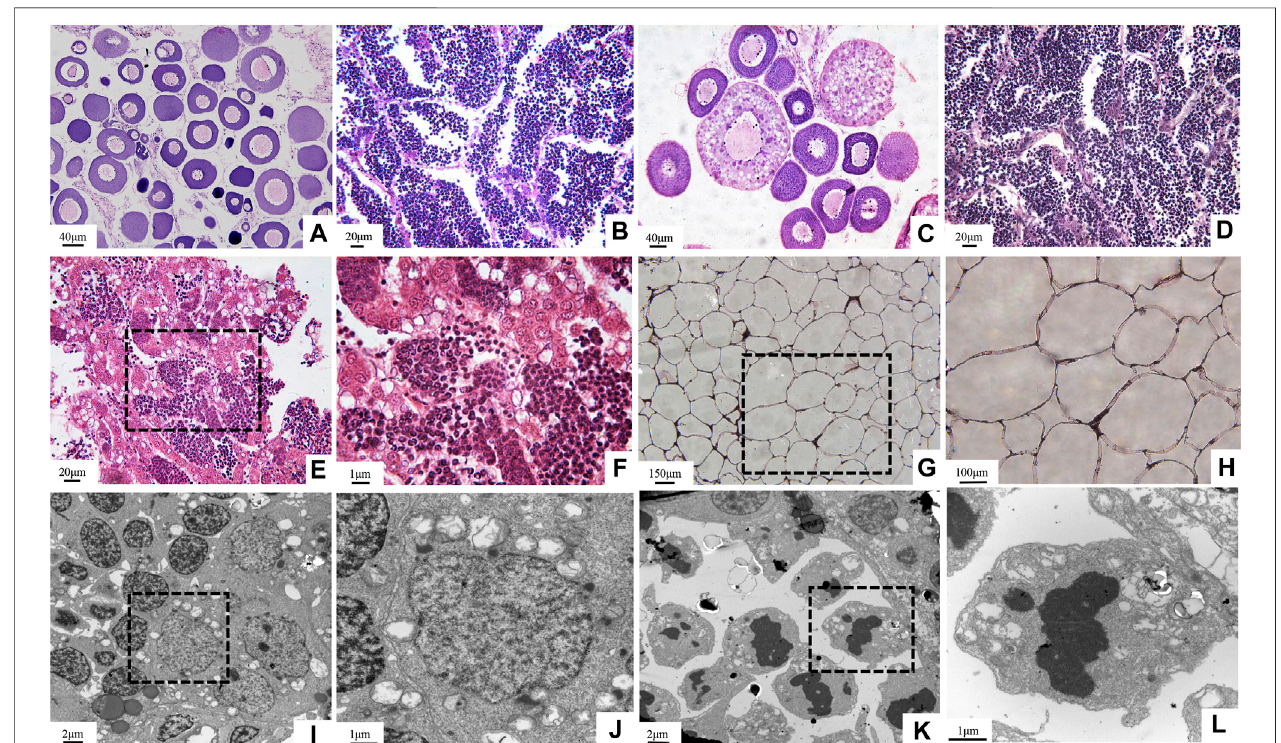
FIGURE 4 | Histological structure of gonads in GFYT hybrids and their parents. (A – H) HE-stained gonads and (I – L) ultrastructure of testis-like gonads of GFYT hybrids. (A) Ovary of GF. (B) Testis of GF. (C) Ovary of YT. (D) Testis of YT. (E,F) Testis-like gonad of GFYT hybrids. (G,H) Fat-like gonad of GFYT hybrids. (I,J) Spermatogoniaandspermatocytesinthetestis-likegonadofGFYThybrids. (K,L) Spermatidswithheteromorphousnucleiinthetestis-likegonadofGFYThybrids.F,H, J, and L, respectively present the ampli fi cation of the dashed box in E, G, I, and K.